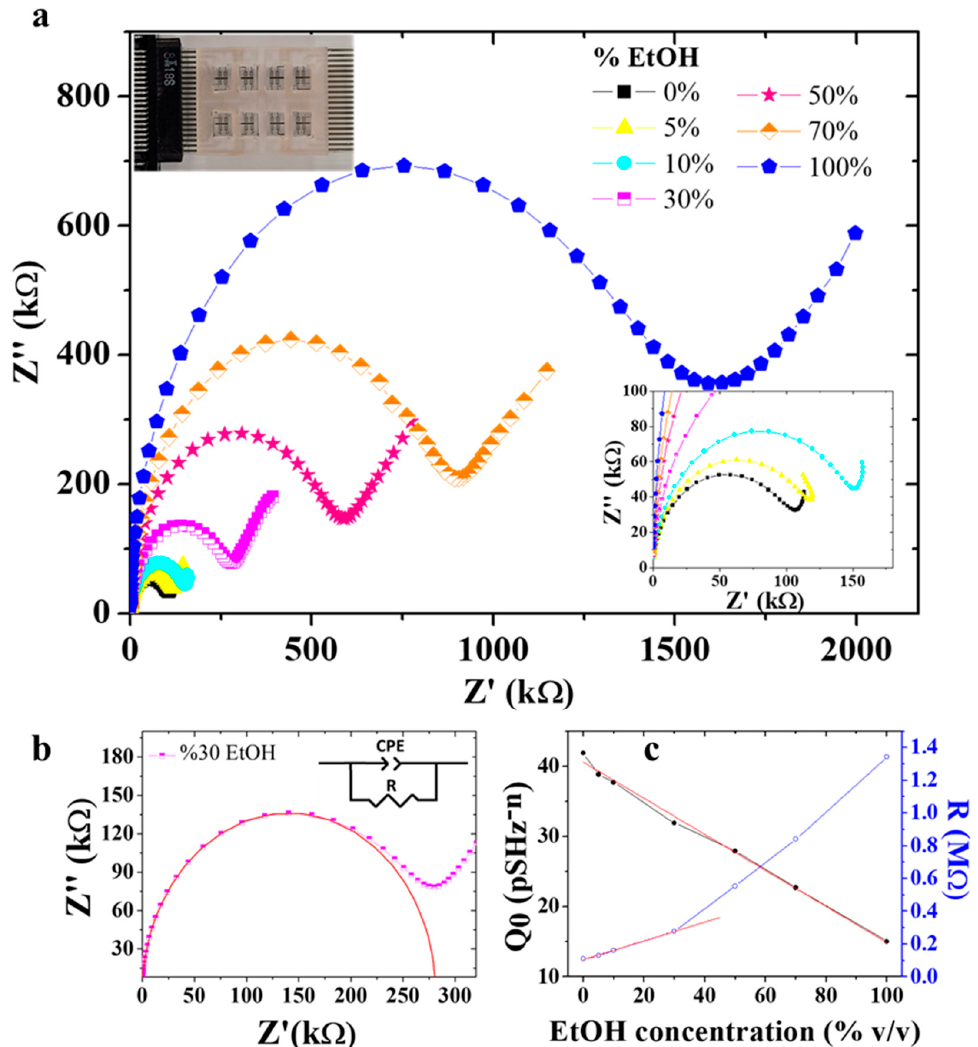
Figure 3. ( a ) Nyquist plots of EIS sensors by varying the %EtOH in DI water. Insets: (top left) optical image of the EIS sensor connected to the PCB for impedance measurements; (bottom down) Details of the impedance responses for pure water (black squares) and with a low concentration of ethanol, 5% (yellow triangles) and 10% (cyan dots). ( b ) Fitting of Nyquist plot recorded for the solution with 30% EtOH (inset: equivalent circuit employed to model the impedance responses acquired for different ethanol contents). ( c ) Q 0 (black full dots) and R (blue empty dots) profiles as a function of ethanol concentration.